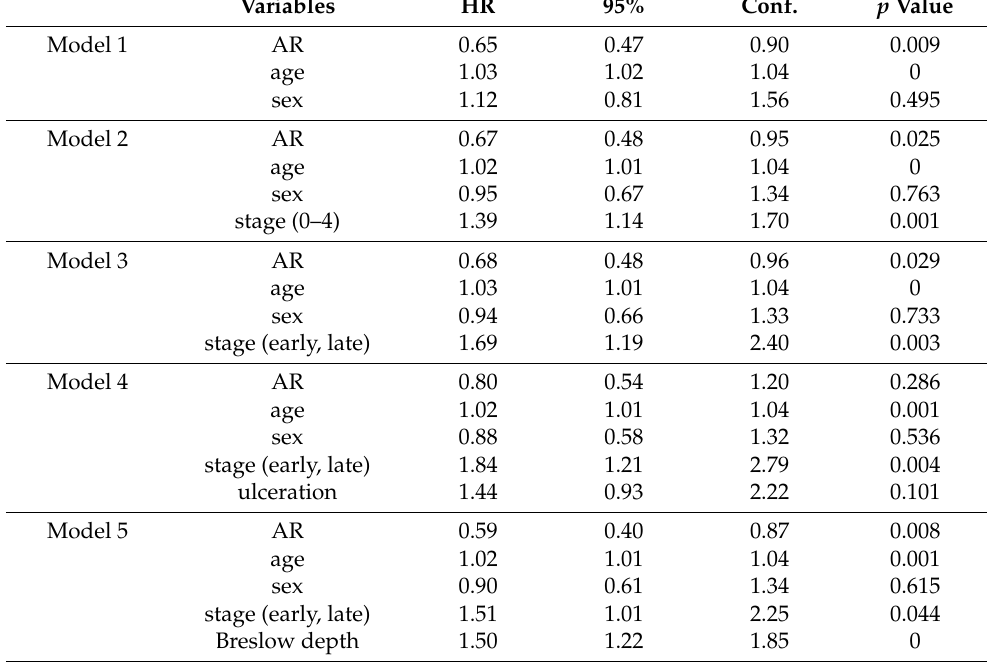
Table A1. Sex difference in overall